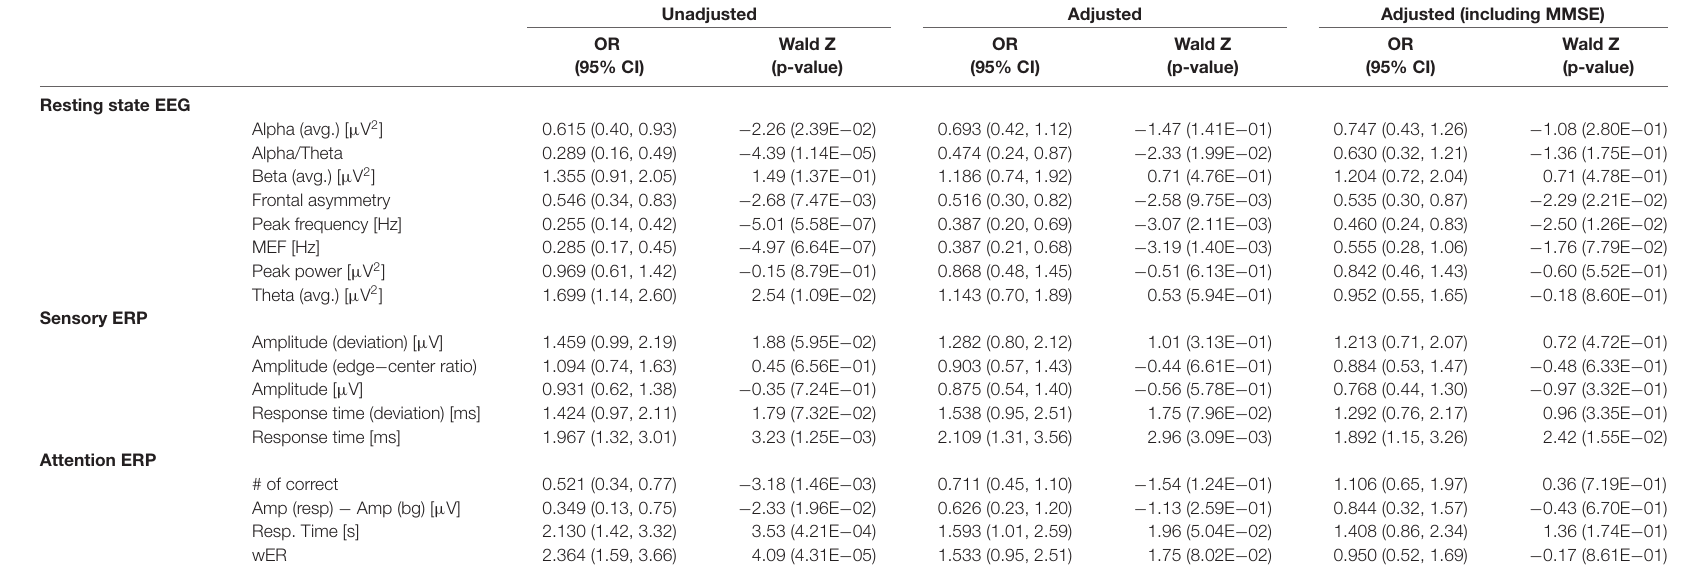
The table shows the exact values for Figure 4 . Due to the small sample size in this study, the covariates related to the disease status (e.g., hypertension, diabetes, and so on) were not included in the multiple logistic regression model. OR (95% CI), Odds ratios with 95% confident interval; Wald Z (p-value), P-value obtains from Wald